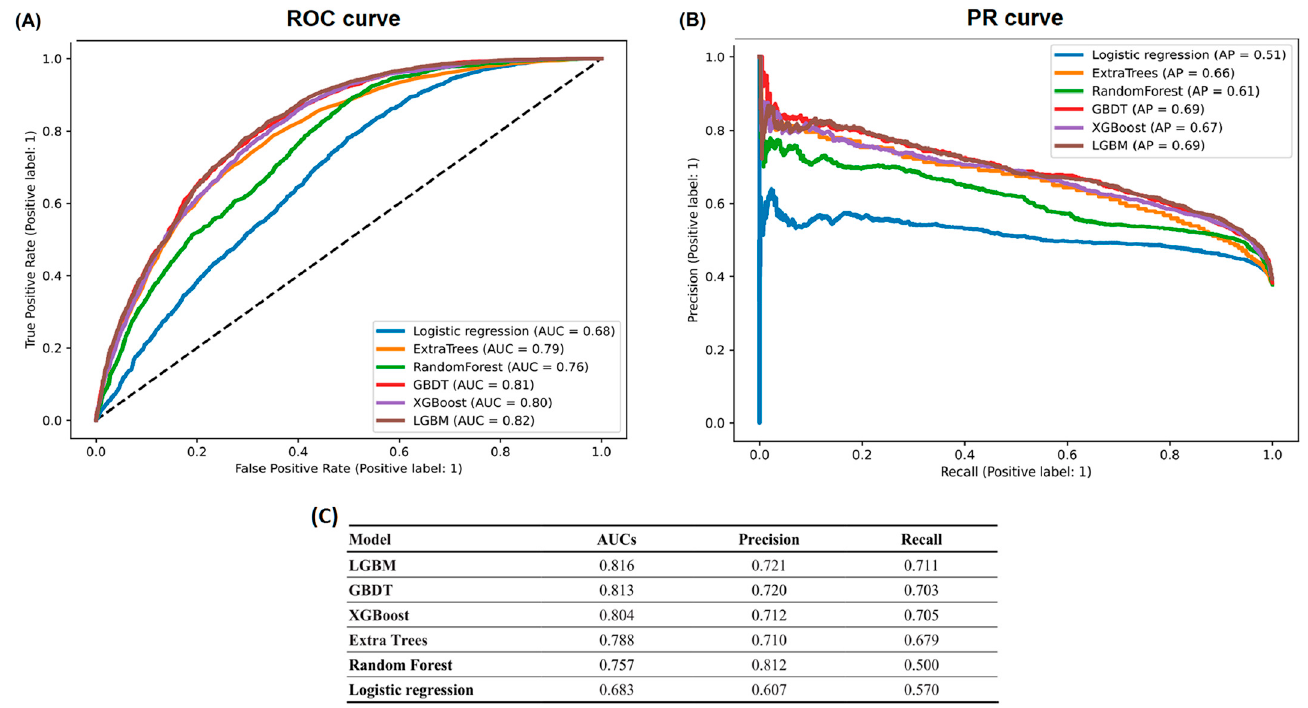
Figure 1. Comparison of ( A ) ROC curve, ( B ) PR curve and ( C ) predictive ability among different machine learning models. Abbreviations: ROC, receiver operating characteristic curve; PR, precision-recall; GBDT, gradient boosting decision tree; XGBoost, extreme gradient boosting; LGBM, light gradient boosting machine LGBM. Abbreviations: ROC, receiver operating characteristic curve; PR, precision-recall; AUC, area under the curve of receiver operating characteristic curve; LGBM, light gradient boosting machine; GBDT, Gradient Boosting Decision Tree; XGBoost, extreme gradient boosting.